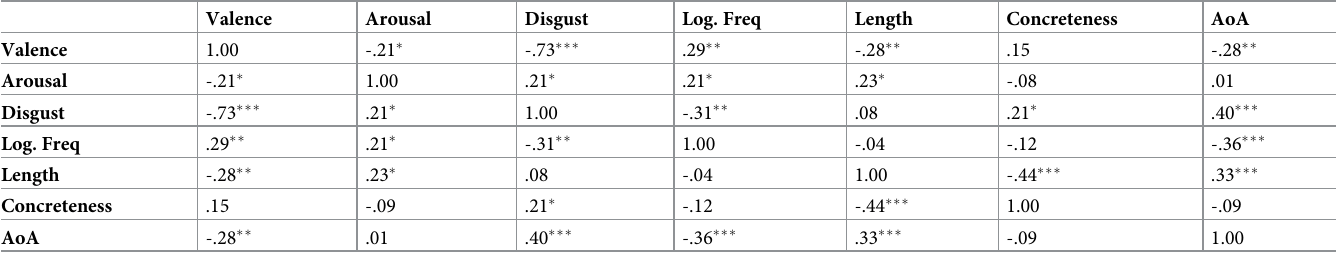
Table 2. Correlation coefficients between stimuli’s